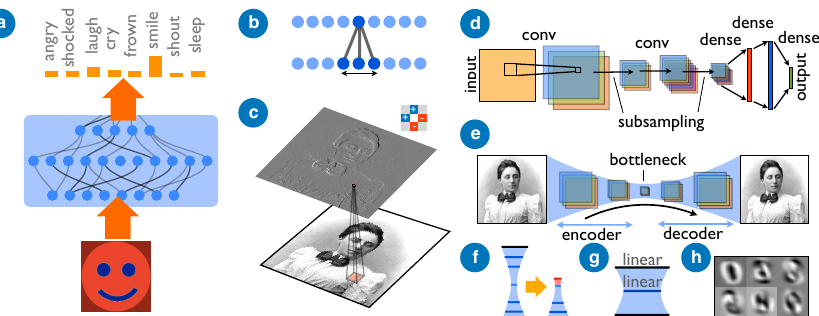
Figure 2: (a) Image classification, where the output neurons signify different